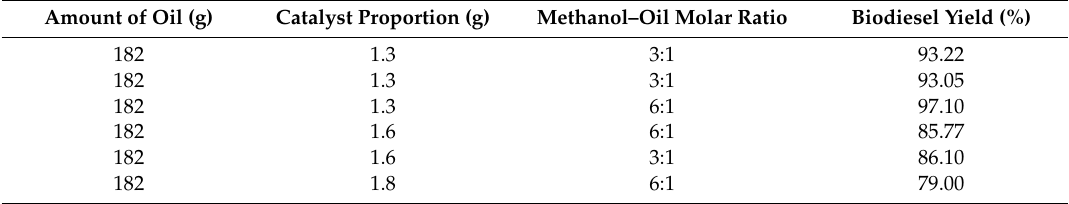
Table 4. Variation of biodiesel yield basing on catalyst and methanol